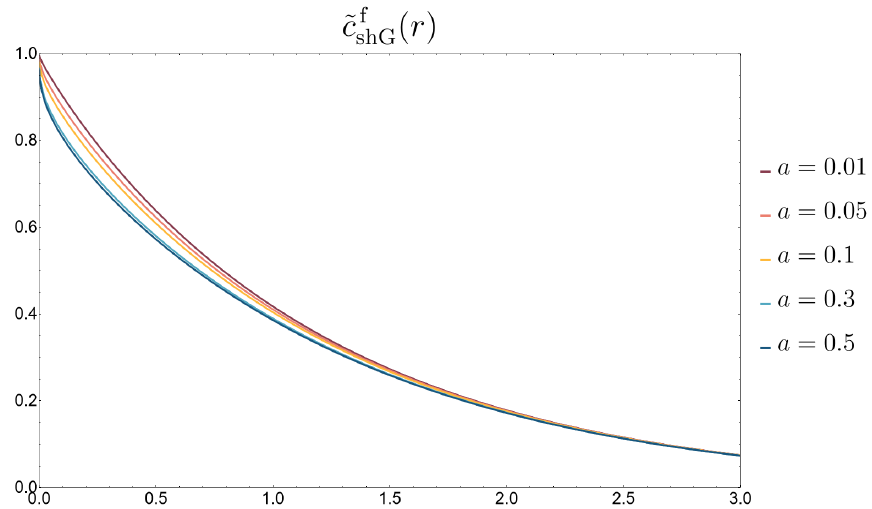
Figure 2. Effective central charge of the fermionic sinh-Gordon model at various values of the coupling a . Numerical solutions were computed using the iterative algorithm described in section 3 with 10 5 points in the interval θ ∈ [ − 10 , 10)